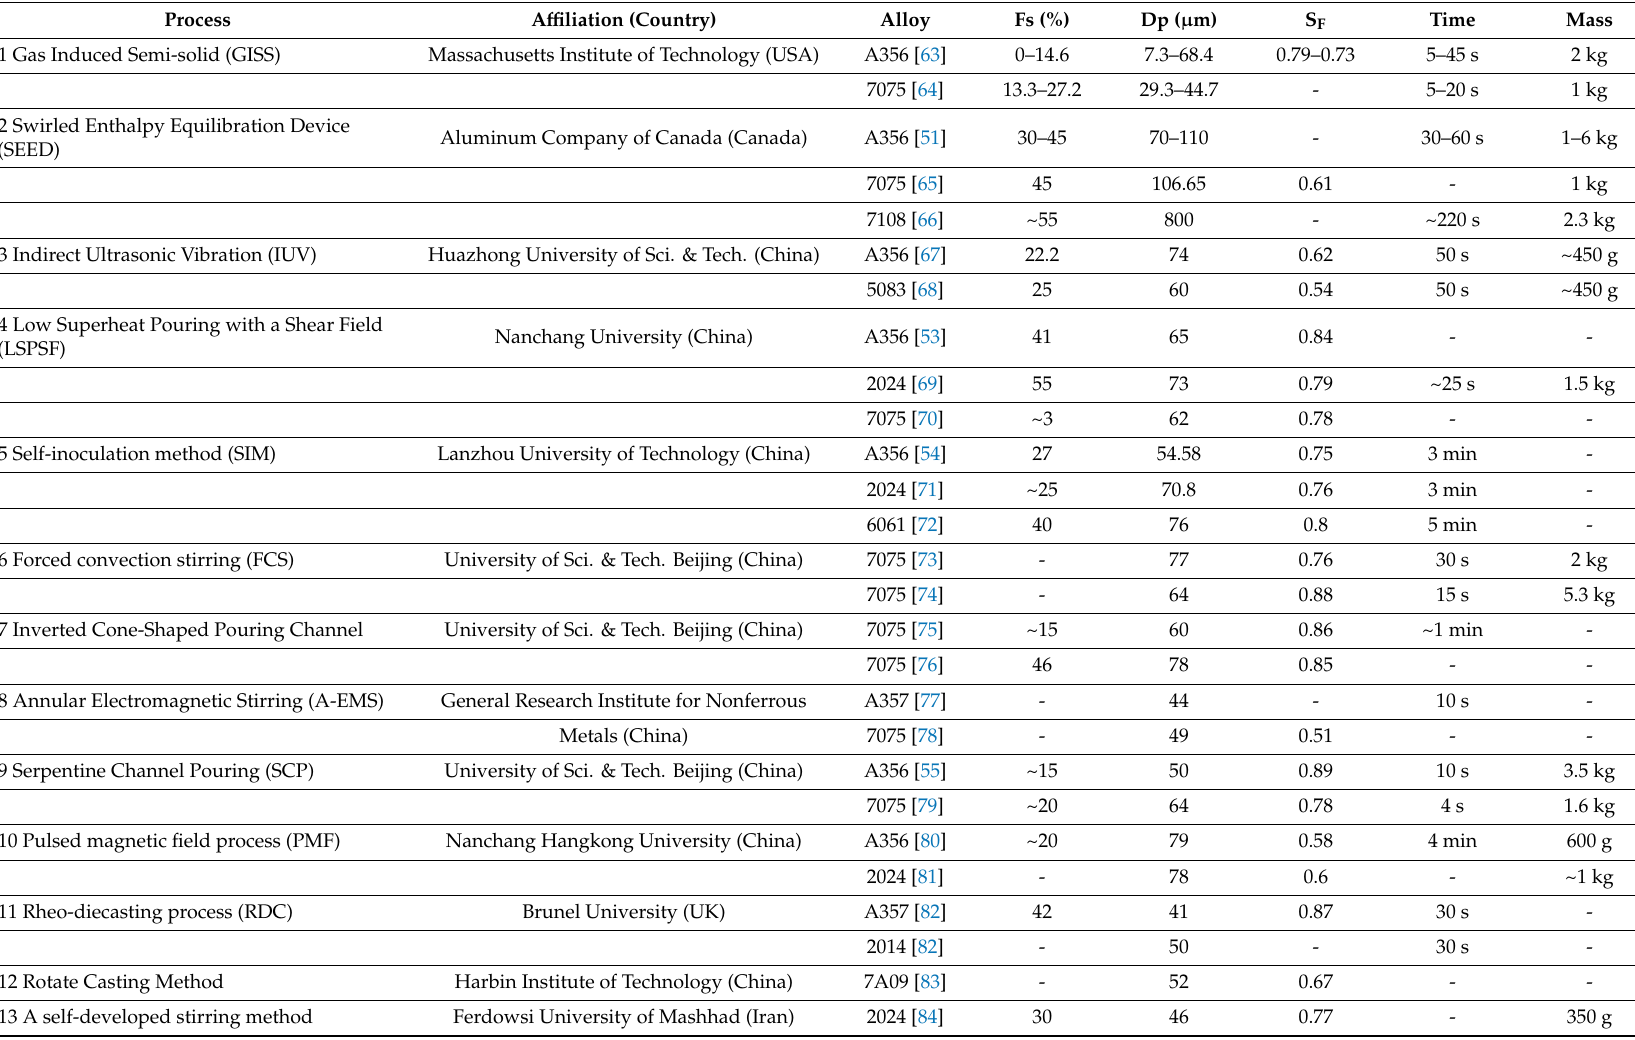
Table 2. Statistics of fraction solid, particle size, shape factor, preparation time and mass of slurry of some cast and wrought alloys prepared by di ff erent method.